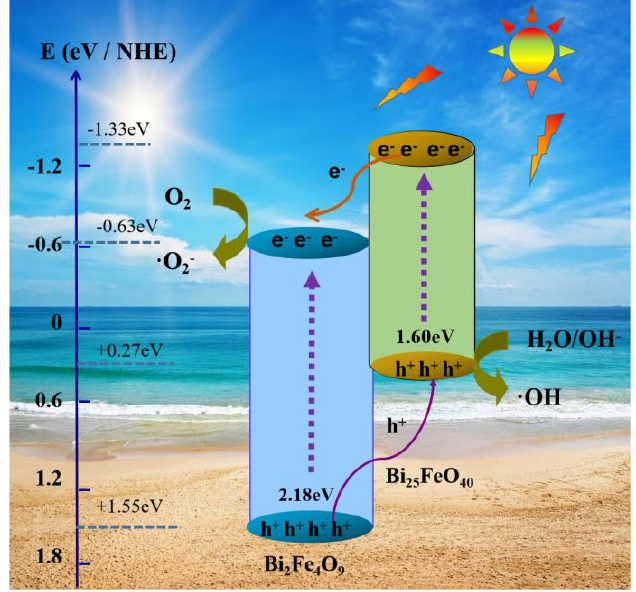
Scheme 1. The schematic illustration of photo-reactive mechanism for Bi 2 Fe 4 O 9 /Bi 25 FeO 40 hetero- structure